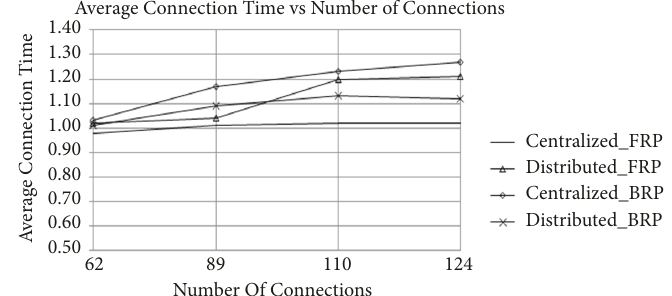
Figure 23: Average connection established time for C-NOM and D-NOM using FRP and BRP with parallel arrivals.